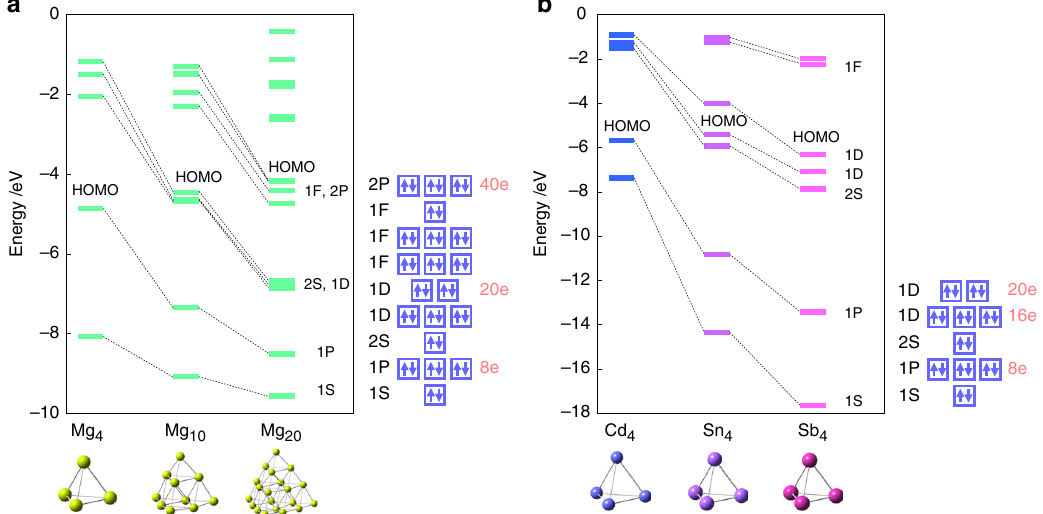
Fig. 4 Orbital levels of different-sized and anisoelectronic clusters. a Mg 4 , Mg 10 , and Mg 20 . b Cd 4 , Sn 4 , and Sb 4 . The symmetry-adapted orbital (SAO)- based electronic con fi gurations are also shown for reference